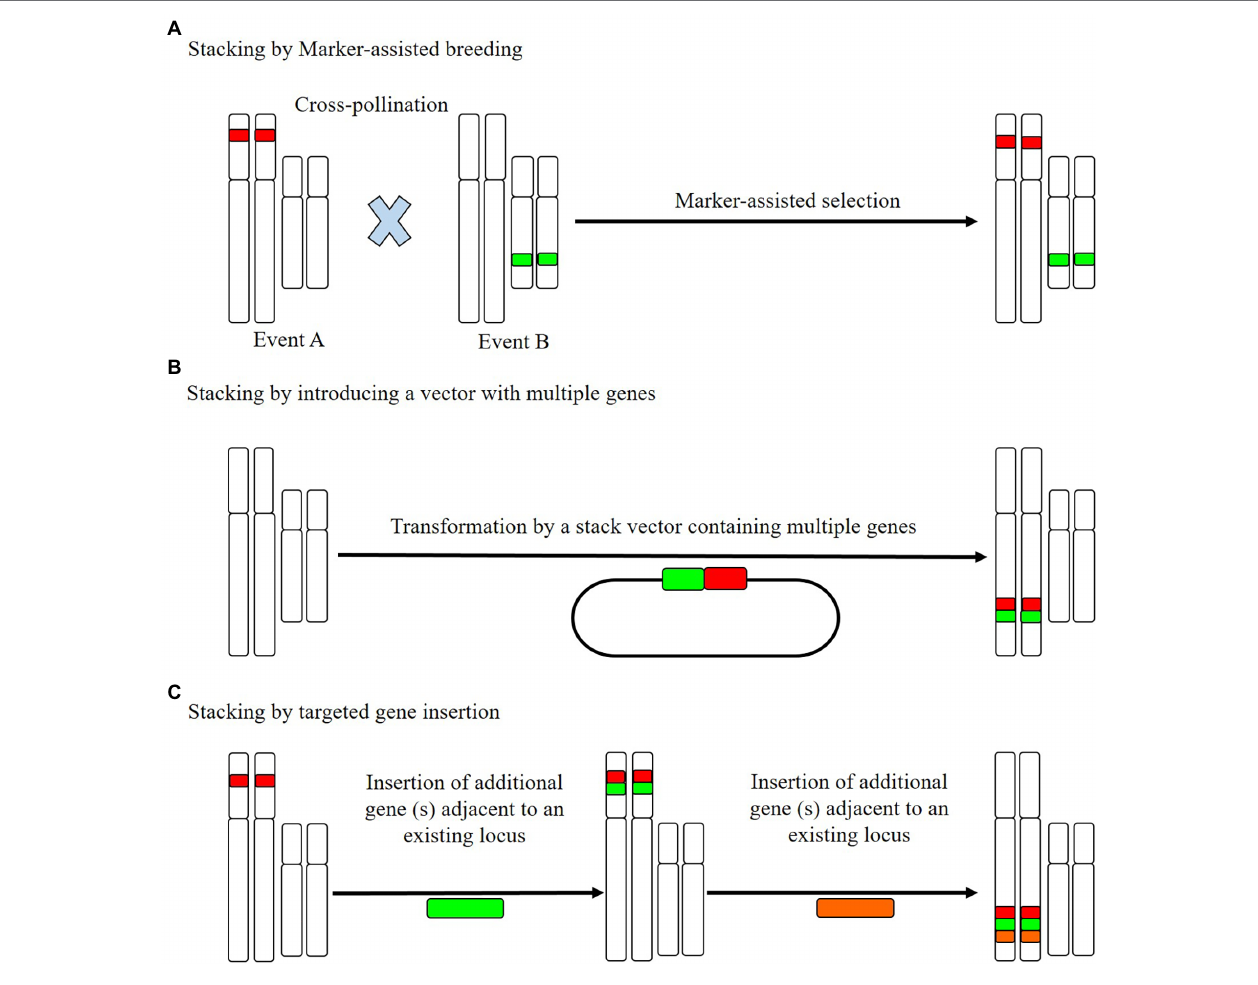
FIGURE 2 | The resistance ( R ) gene stacking method. (A) Cross-pollinated individuals, based on established trait loci, stack marker-assisted breeding and combine the combined trait loci for marker-assisted selection of the offspring. (B) A single transgene stacking event can be completed by integrating multiple genes into a single stack vector and introducing these simultaneously. (C) Targeted insertion stacking aims to insert new genes near established loci. To stack a large number of genes, this process can be repeated. The stacked genes in B and C are genetically related, such that they can be readily inserted at a single